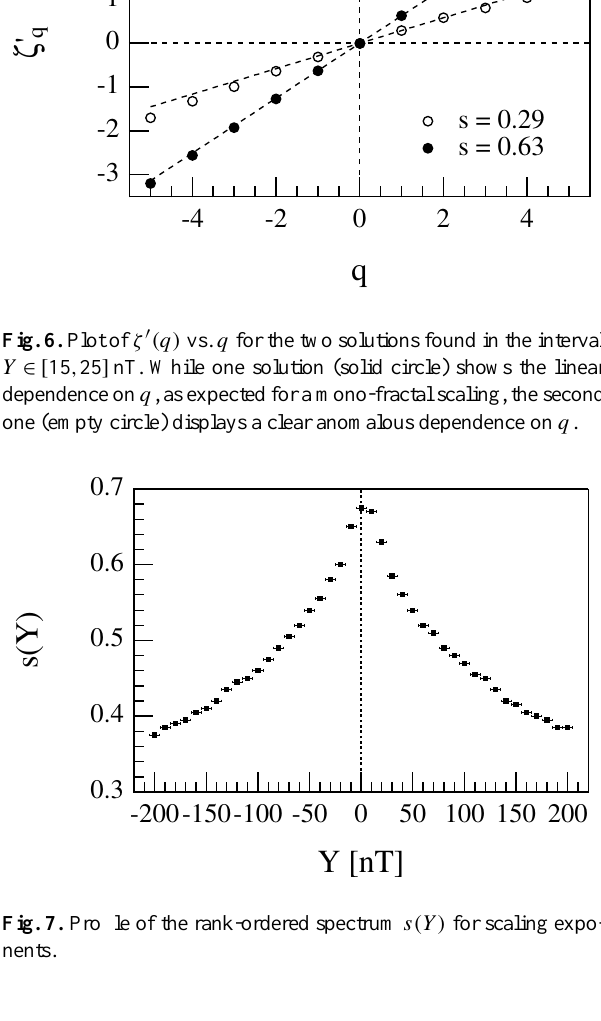
Fig. 6. Plot of ζ 0 ( q ) vs q for the two solutions found in the interval Y ∈ [15 , 25] nT . While one solution (solid circle) shows the linear dependence on q , as expected for a mono-fractal scaling, the second one (empty circle) displays a clear anomalous dependence on q .